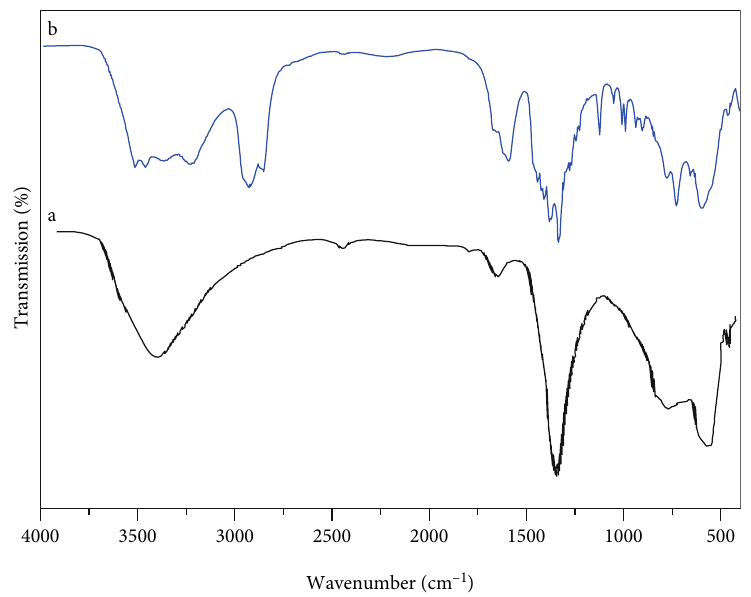
Figure 1: The FT-IR spectra of (a) LDH and (b) LDH-[Ni(EDTA)] 2- .